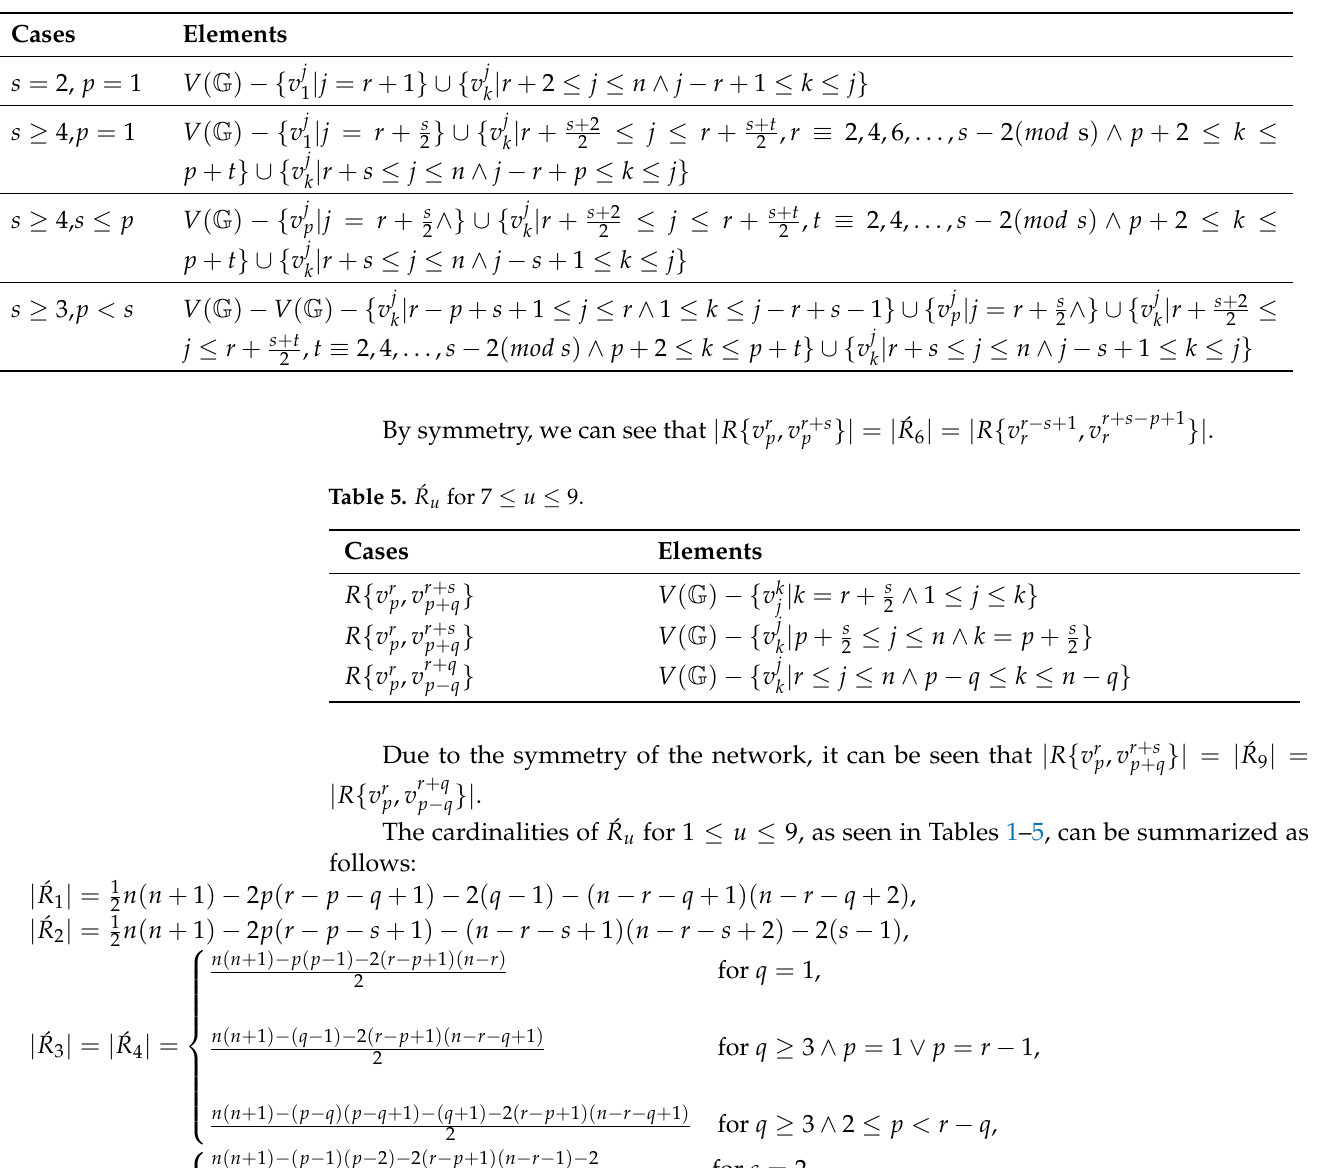
Table 4. ´ R 5 = R { v r p , v r + s p } .